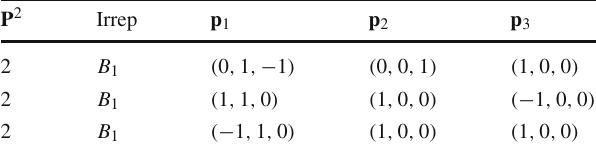
Table 7 Possible three-pion individual momenta in the (cid:6) = B 1 irrep with total momentum P 2 = 2